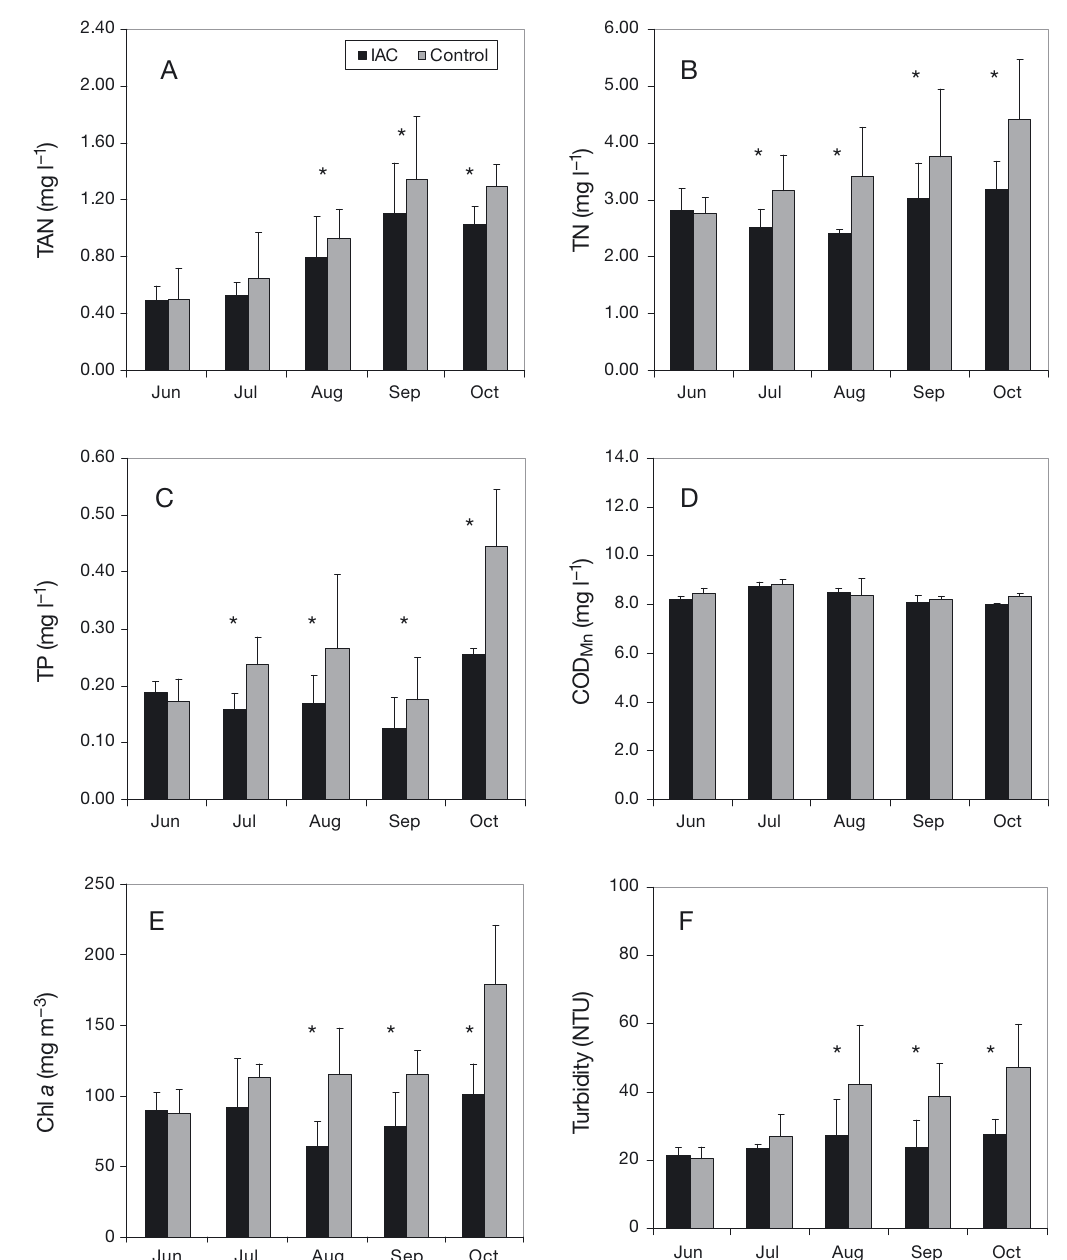
Fig. 1. Fluctuations in (A) total ammonia nitrogen (TAN), (B) total nitrogen (TN), (C) total phosphorus (TP), (D) chemical oxy- gen demand (COD Mn ), (E) chlorophyll a (chl a) concentrations and (F) turbidity in the Chinese soft-shelled turtle Pelodiscus sinensis ponds during the 4 mo experimental period. Values are means (±SD) of 3 replicate ponds per sampling time in each treatment. IAC: Ipomea aquatica treatment. ( * ) indicates significant difference between treatments (p <